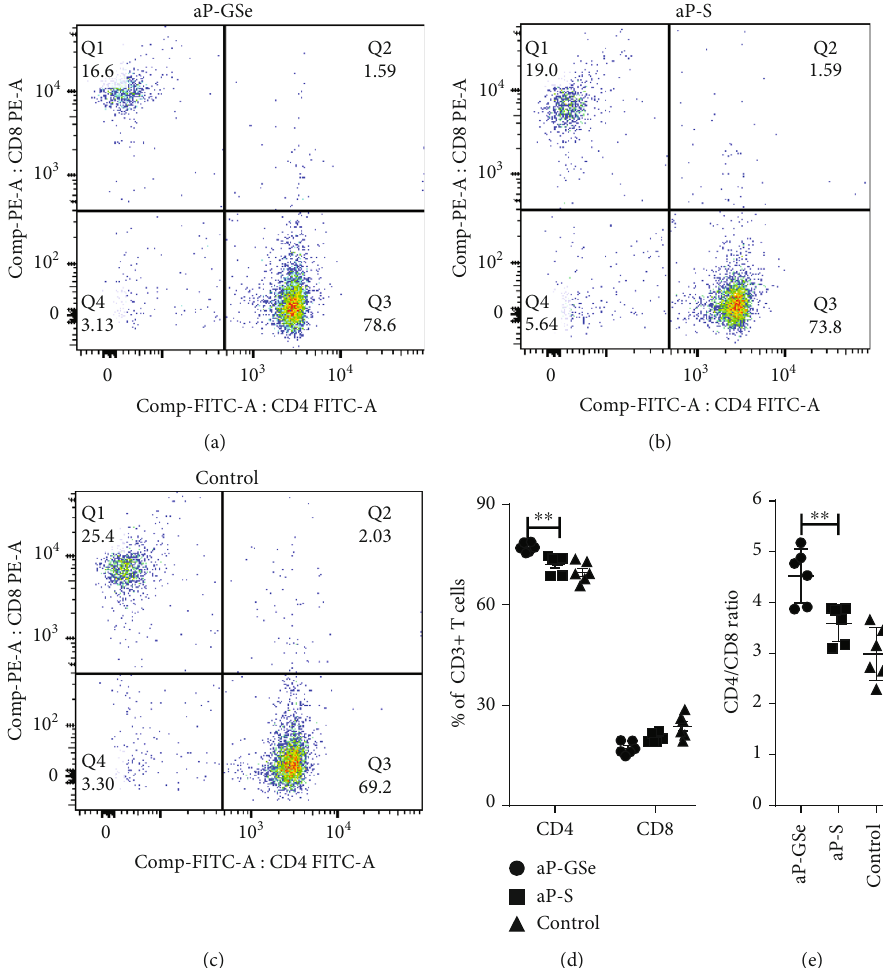
Figure 4: Quanti fi cationofsplenicCD3 + CD4 + andCD3 + CD8 + TcellsubpopulationsandtheCD3 + CD4 + /CD3 + CD8 + ratio.Mice( n = 6 /group) received twice i.m. injection of aP-GSe or aP-S at two weeks apart and animals injected with saline served as a control. Splenocytes were prepared 2 weeks after boost immunization for analysis of CD3 + CD4 + and CD3 + CD8 + T cell subpopulations by fl ow cytometry. Data are expressed as the mean ± SE . ∗∗ p < 0 : 01 vs. aP-S group as indicated by one-way ANOVA with the LSD